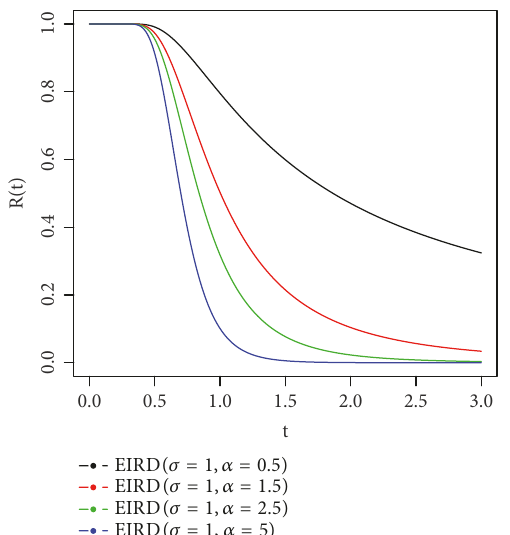
Figure 3: Curve of reliability function of EIRD with different shape parameters.